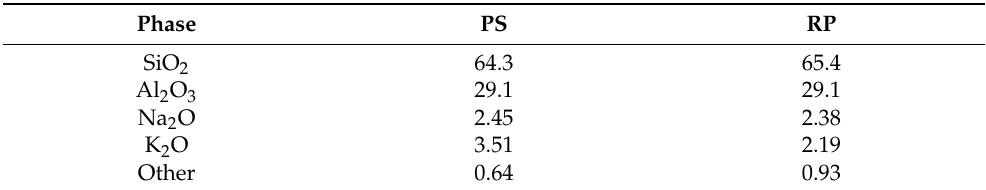
Table 4. Chemical composition (weight %) of PS and RP used in this paper as obtained by EXD